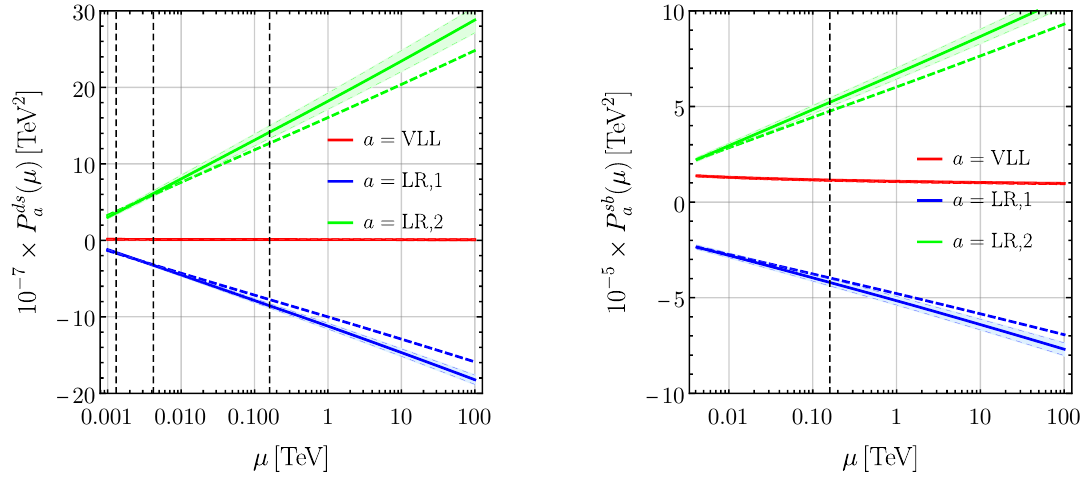
Figure 1 . The QCD RG evolution at NLO [solid] versus LO [dashed] for some of the coefficients P ij µ ) for K 0 − ¯ K 0 [left] and B s − ¯ B s mixing [right]. The coloured band around the NLO results a ( shows the hadronic uncertainties from the matrix elements. The vertical dashed line indicates µ ew = 160 GeV and for K 0 − ¯ K 0 mixing also the N f = 4 , 5 flavour thresholds. For scales larger than µ ew the full SMEFT RG evolution should be used in principle, including Yukawa and the full SM gauge sector